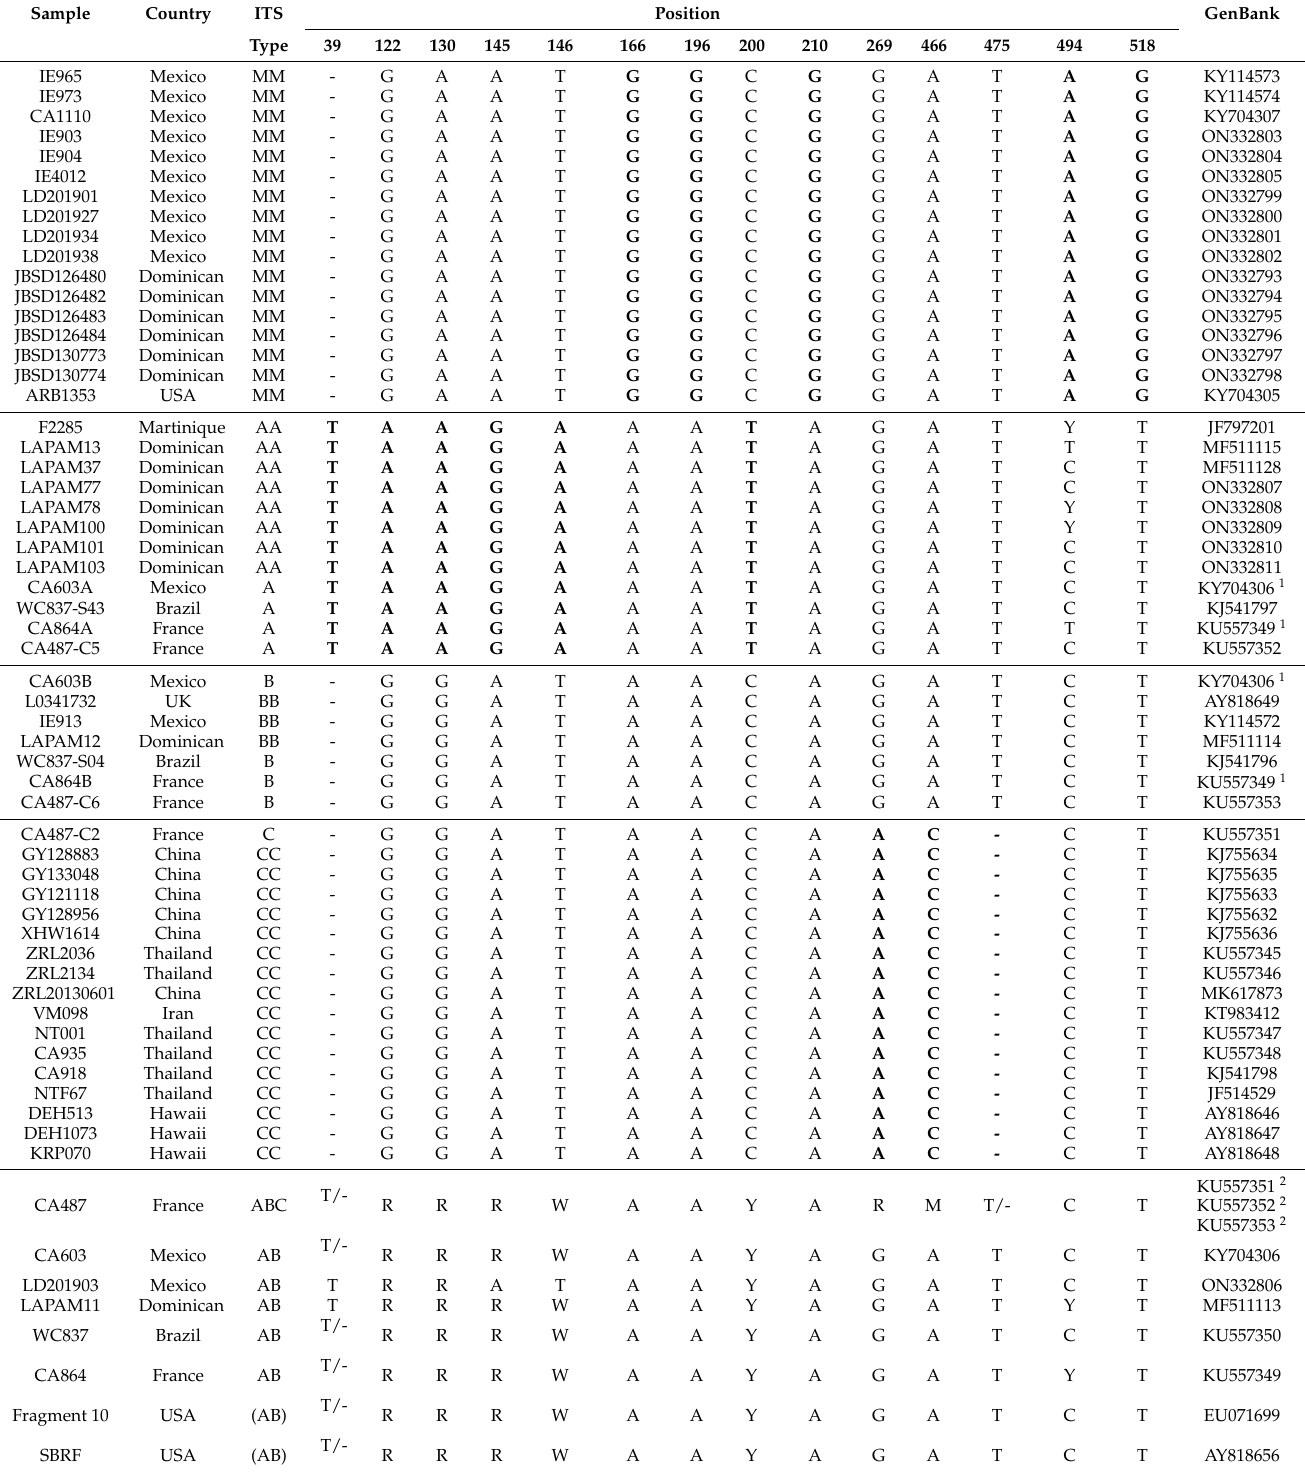
Table 2. Different types of ITS within Agaricus subrufescens and A. macrochlamys based on characteristic polymorphisms at 14